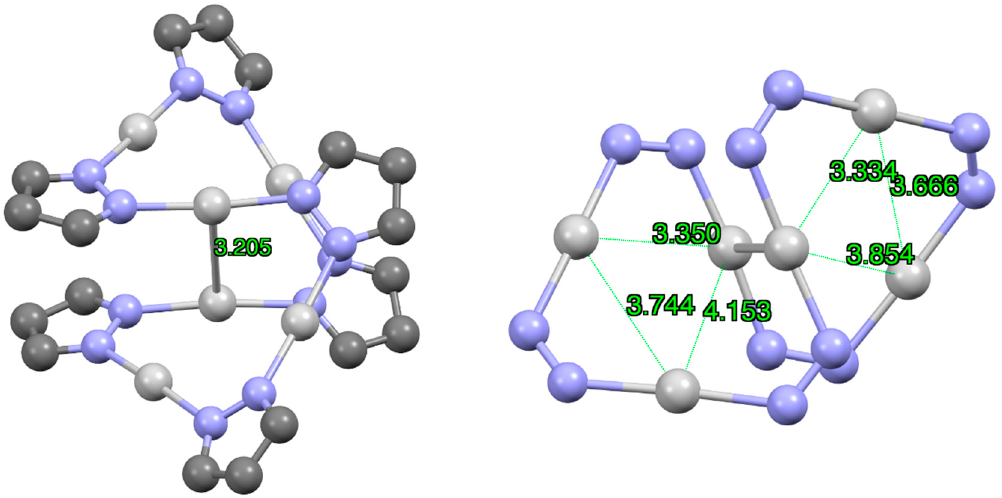
Figure 9. Two views of QEJJEX. Only the silver atoms and the pyrazolate rings are represented. Left Ag···Ag distance between loops; right Ag···Ag distance in the quasi-triangles.